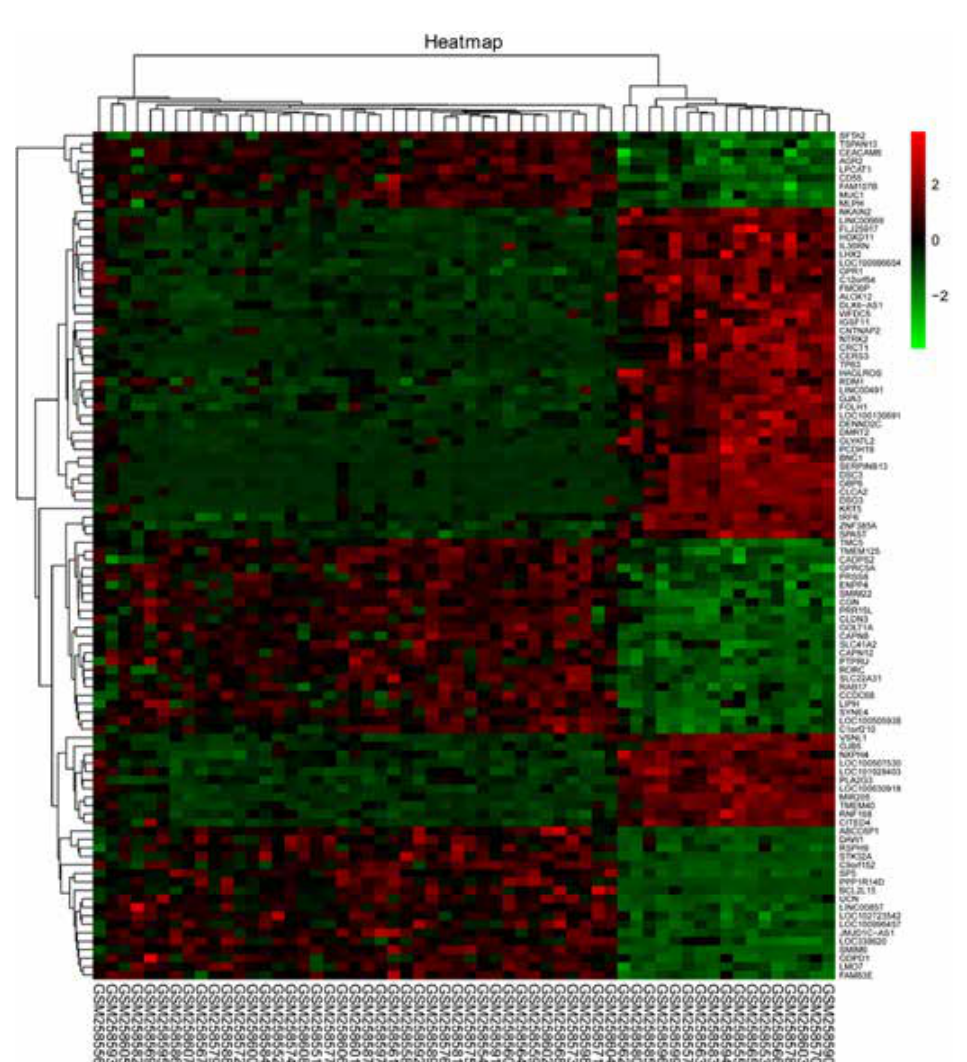
Figure 1 Heatmap of top 50 upregulated and downregulated genes differentially expressed genes (DEGs), red ones represented upregulation and green represented downregulation.